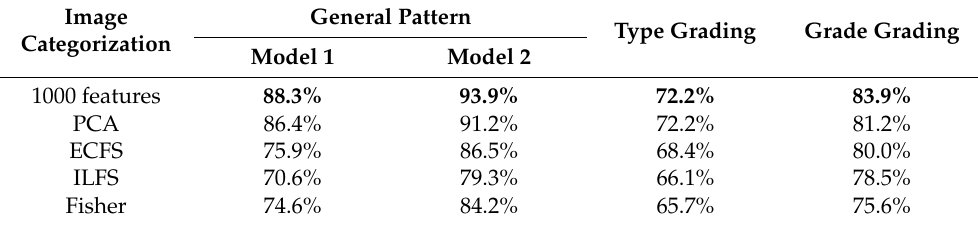
Table 8. Testing accuracy results using 50 most significant automatic